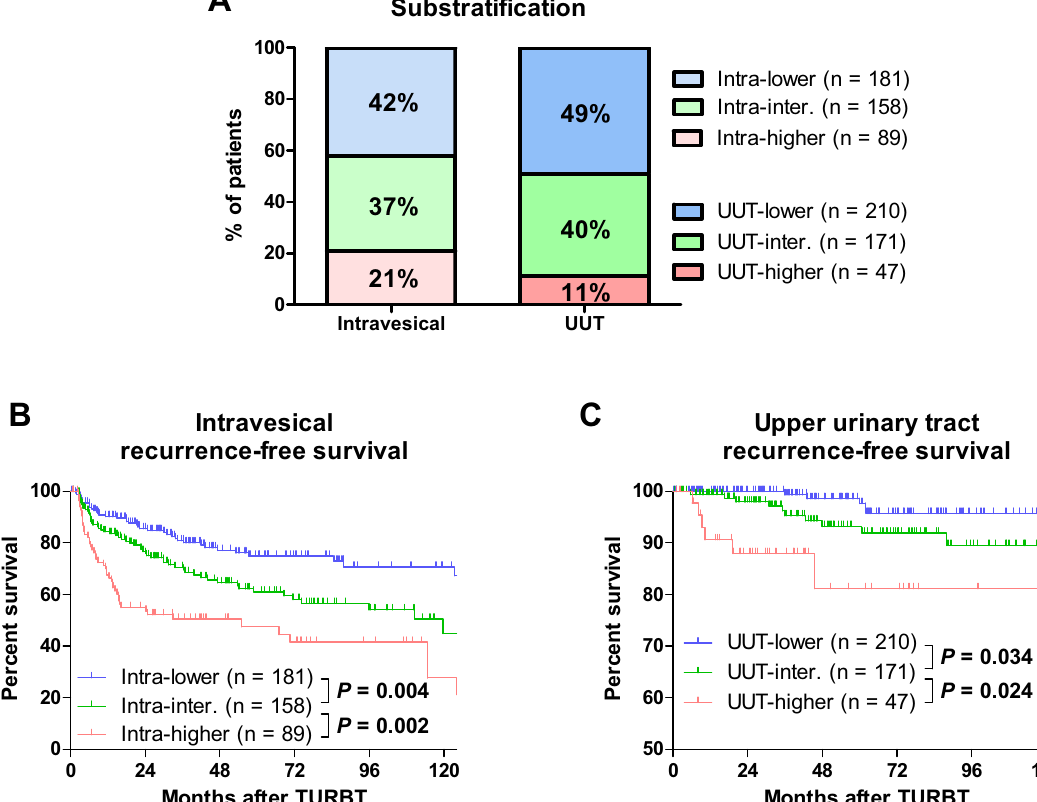
Figure 1. Substratifications and oncological outcomes. Substratifications of high-risk non-muscle-invasive bladder cancer based on risk scores ( A ). Intravesical ( B ) and upper urinary tract (UUT) recurrence-free survival rates ( C ) were evaluated using the Kaplan–Meier method and compared using the log-rank test. TURBT, transurethral resection of bladder